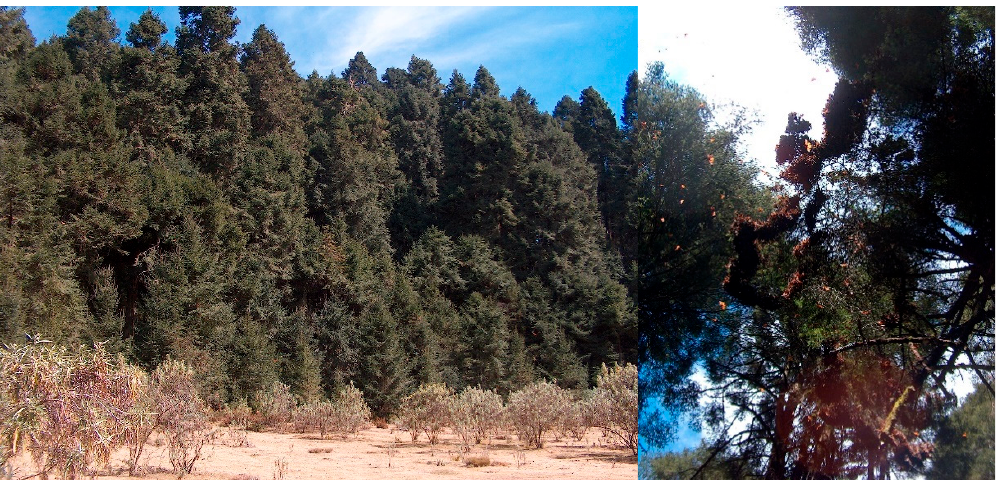
Figure 5. Panoramic view of the La Joya location ( left ) and clusters of monarch butterflies on an oyamel fir tree ( right ). Photos by Victor J. Arriola-Padilla.